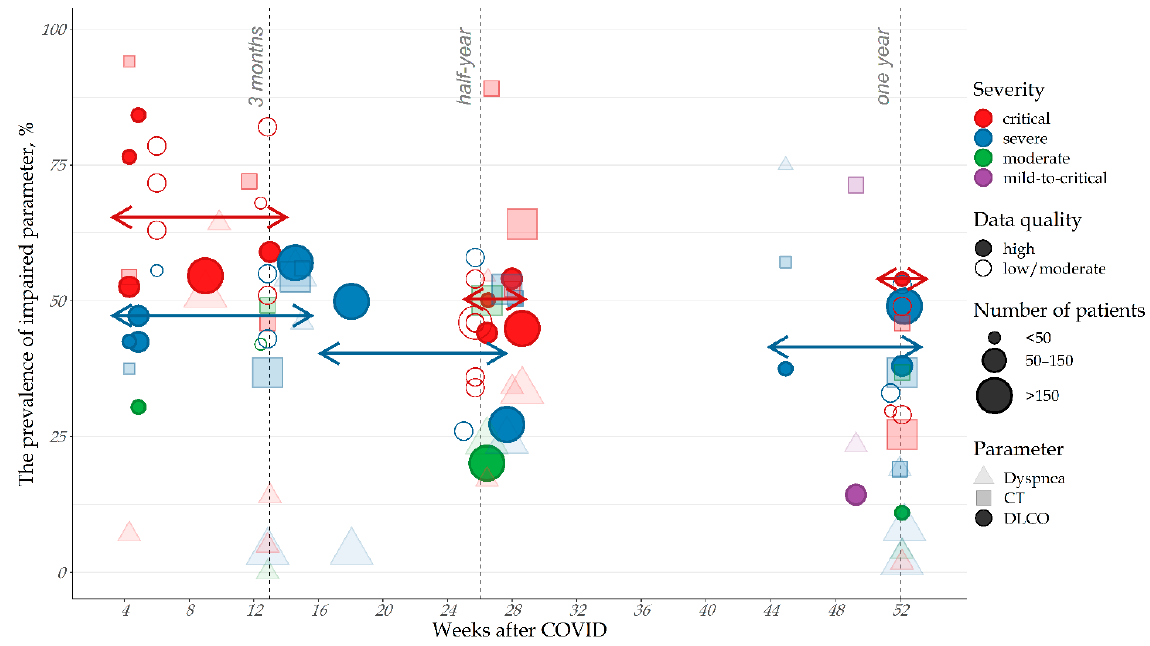
Figure 1. The prevalence of the pulmonary gas exchange impairment, depending on the severity of the disease and the time elapsed since the infection onset. (see Table S1 for more information.) Given that the proportion of severely ill patients (dyspnea, hypoxia, or >50% pulmonary involvement) is 17%, and the proportion of critically ill patients is 2% (respiratory failure, shock, or multiple-organ-dysfunction syndrome) [32], it is possible to estimate the annual number of new OP-like PCPS cases in the United States (990,000), the UK (280,000), and Germany (545,000) (Figure 2). The extrapolation of these data from developed countries provides the approximate annual global incidence of 7 million of new OP-like PCPS cases.